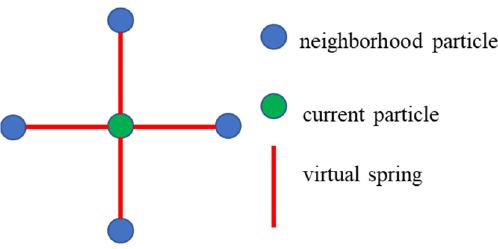
Figure 3. A representation of particle internal force constraints.